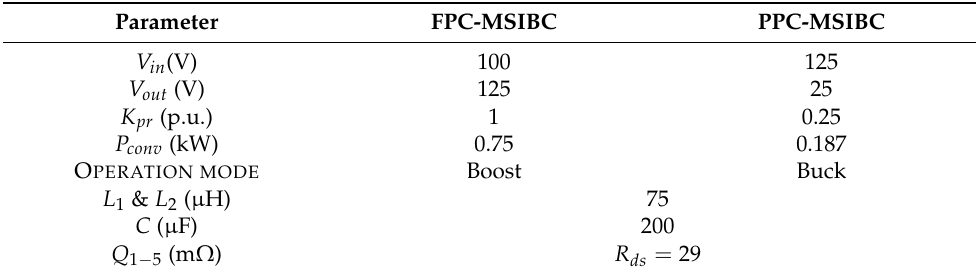
Table 5. Estimated design parameters for each double-inductor topology.